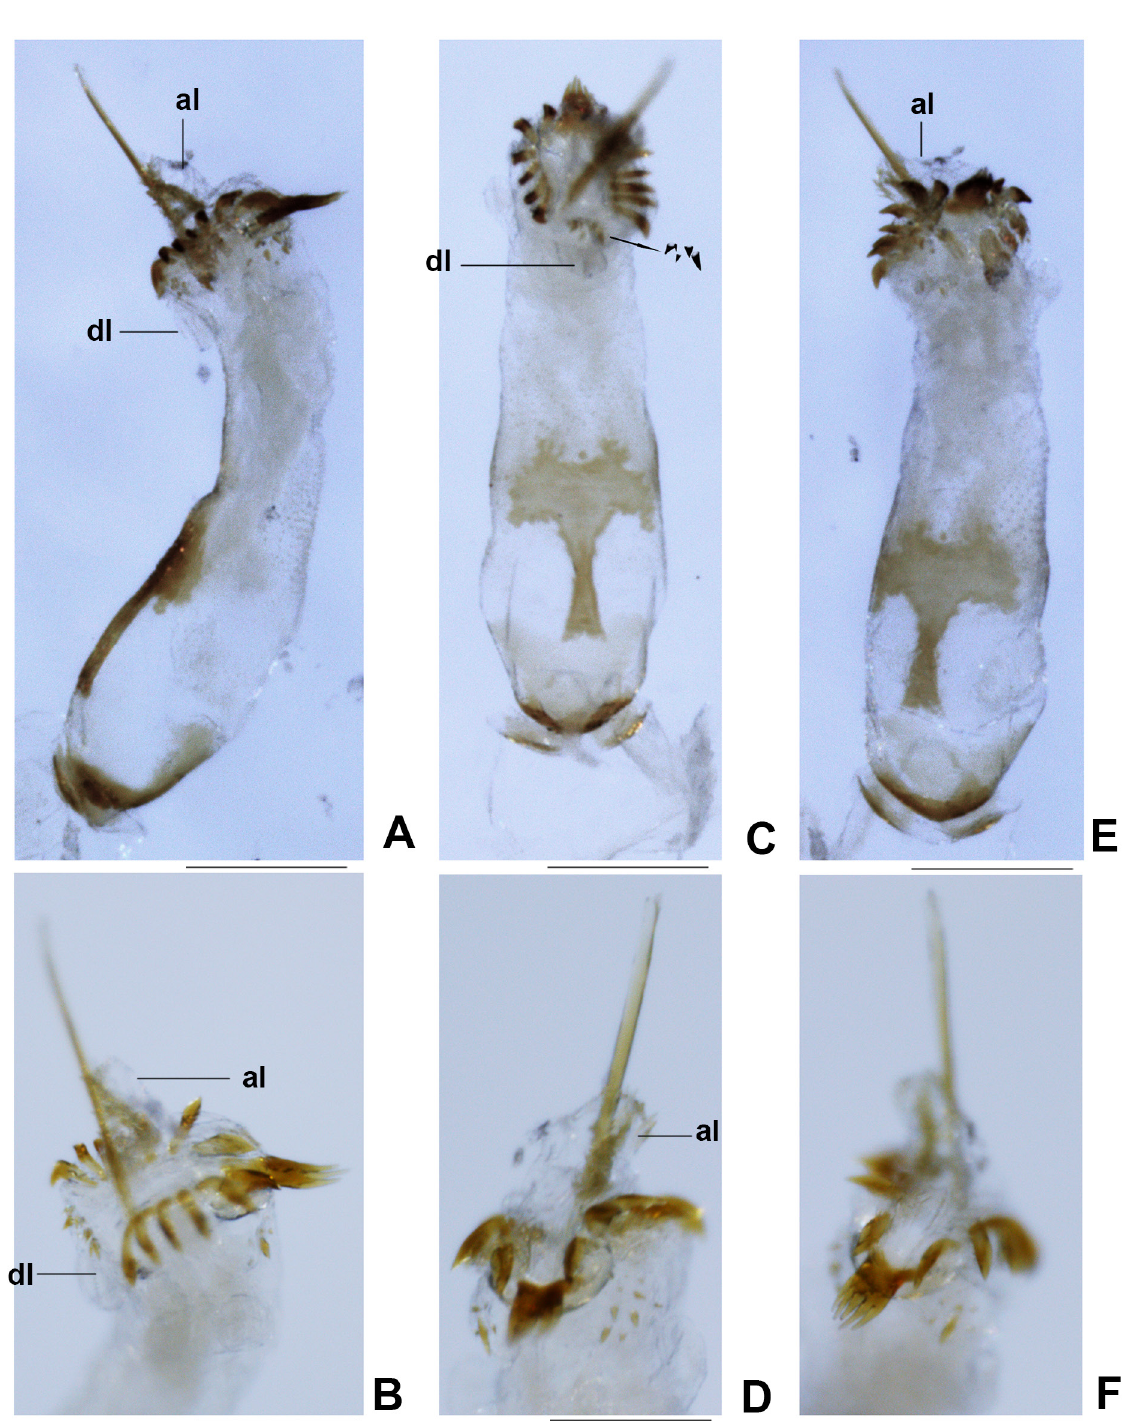
Fig. 2. Chinoperla changjiangensis sp. nov., ♂, paratype (HIST). A . Aedeagus, lateral view. B . Apex of aedeagal sac, lateral view. C . Aedeagus, dorsal view (diagram of dorsoapical spines indicated by arrow). D . Apex of aedeagal sac, ventral view. E . Aedeagus, ventral view. F . Apex of aedeagal sac, oblique ventral view. Abbreviations: see Material and methods. Scale bars = 0.25